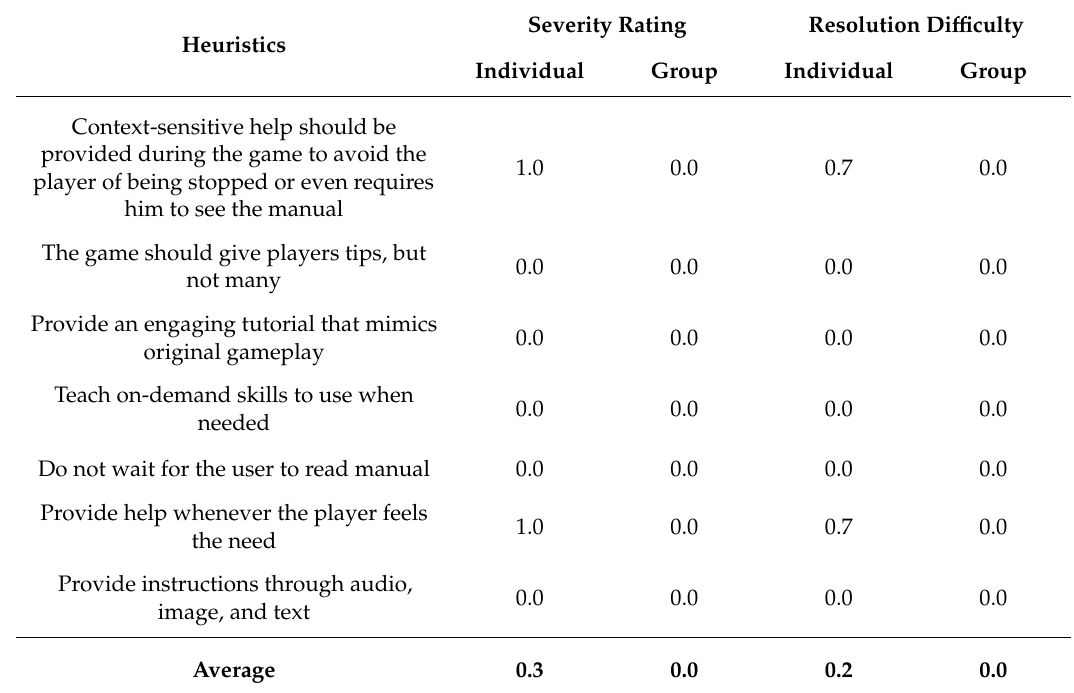
Table 9. Heuristics analysis of the game’s help